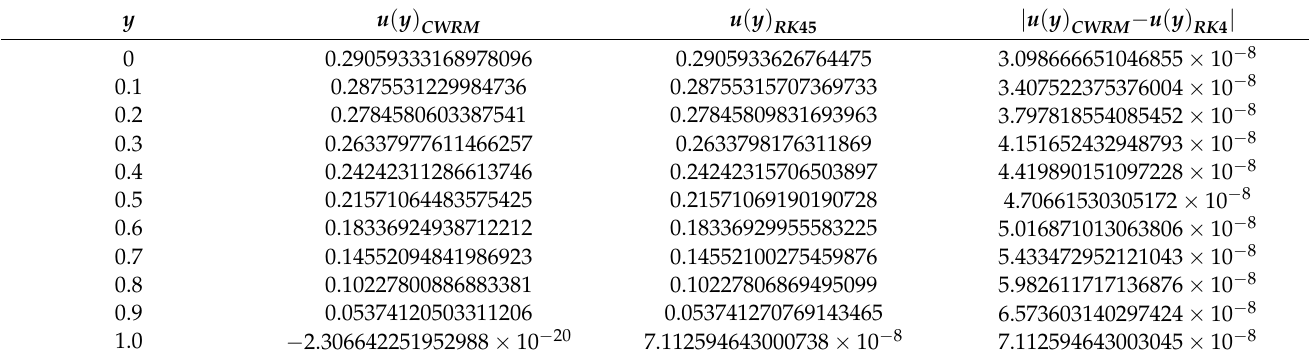
Table 1. Numerical validation when λ = 0.5, (cid:101) = 0.2, m = 0.5, Bi = 20, α 1 = 0.1 = α 2 , κ = 0.5, G = γ = H = r = S =